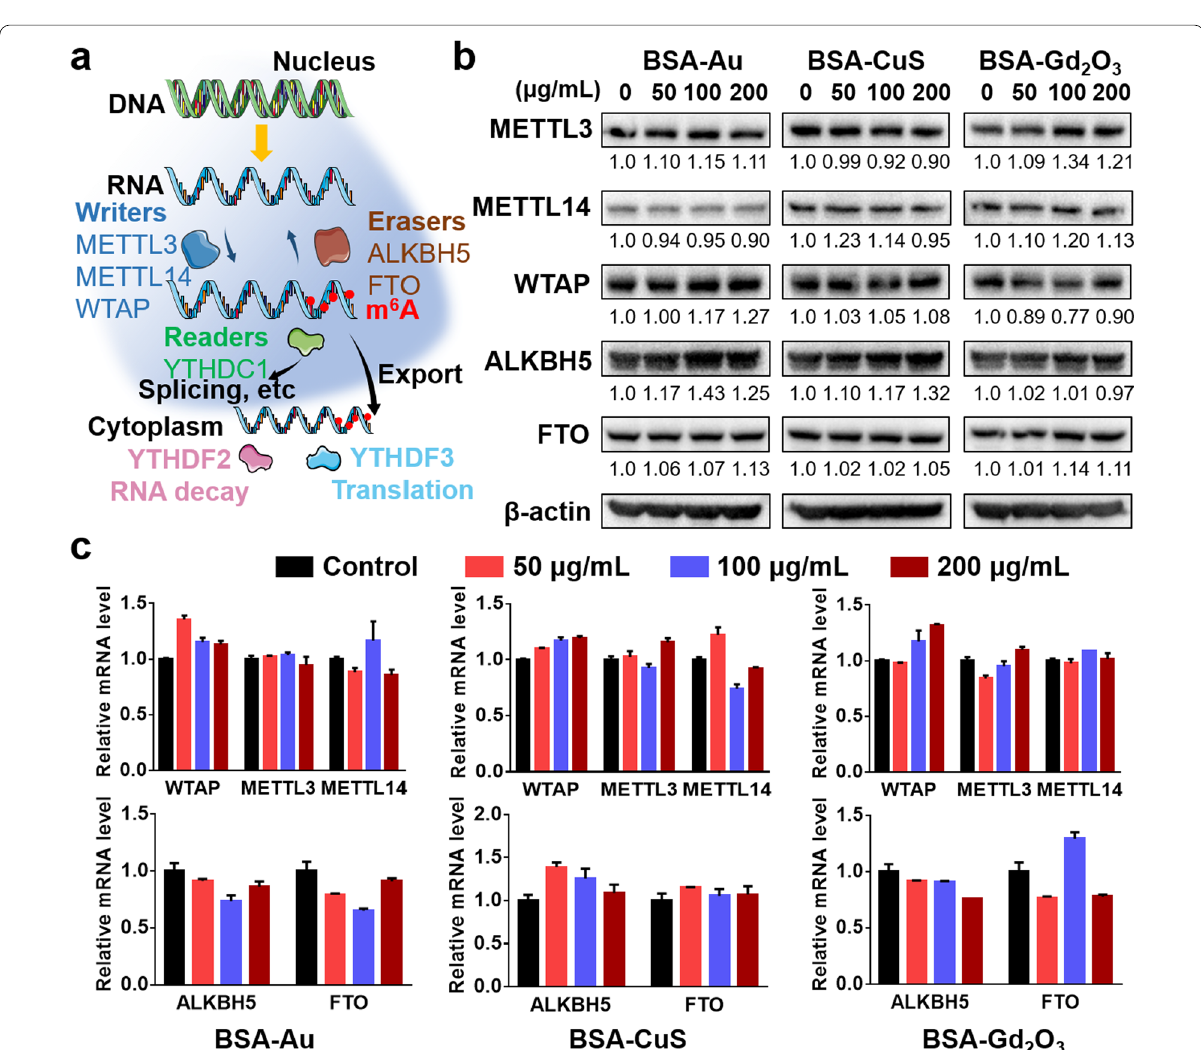
Fig. 5 Expression changes of m 6 A-related writers and erasers upon BSA-templated NPs exposure. a Schematic representation of the m 6 A manipulation and function. b Western blot analysis of m 6 A-related protein expression in HEK293T cells upon BSA-templated NPs treatment for 24 h. Left panel: exposure to BSA-Au NPs, middle panel: exposure to BSA-CuS NPs, right panel: exposure to BSA-Gd 2 O 3 NPs. A total of 30 μg protein was loaded (β-actin was used as a control for loading). c Relative mRNA levels of m 6 A-related genes in HEK293T cells upon NPs exposure for 24 h. Left panel: exposure to BSA-Au NPs; middle panel: exposure to BSA-CuS NPs; right panel: exposure to BSA-Gd 2 O 3 NPs. Data were shown as the mean ±